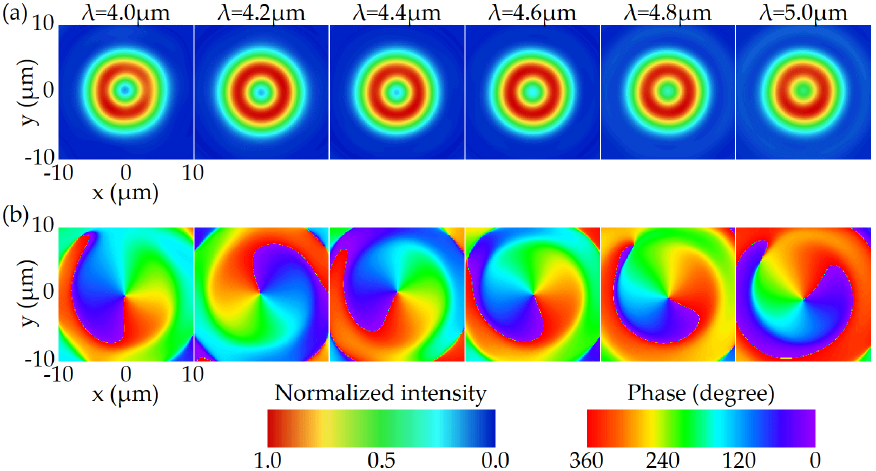
Figure 3. The simulated electric field distribution for the FVBG with regular negative dispersion on the focal plane between 4.0 and 5.0 μ m. ( a ) Normalized intensity. ( b ) Phase. the focal plane between 4.0 and 5.0 µ m. ( a ) Normalized intensity. ( b )